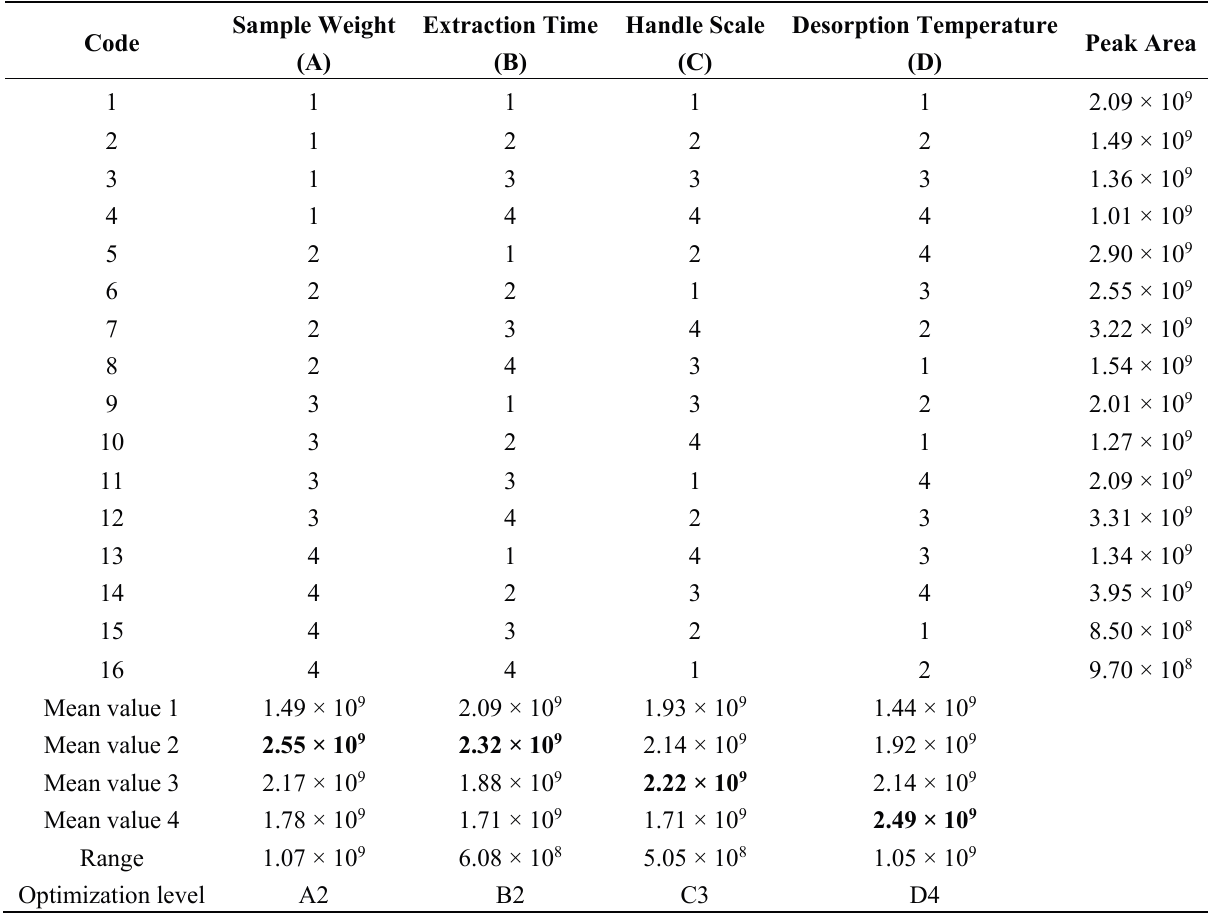
Table 1. Result of L 16 (4 4 ) orthogonal test for optimization of the HS-SPME